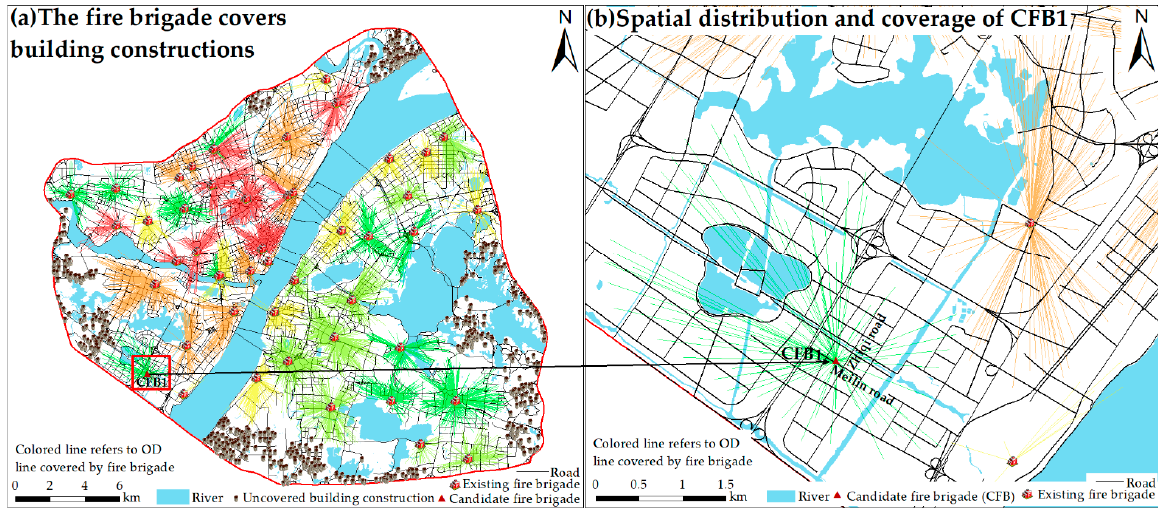
Figure 16. For experiment (2), the spatial distribution of 48 fire brigades in all building construction sites.